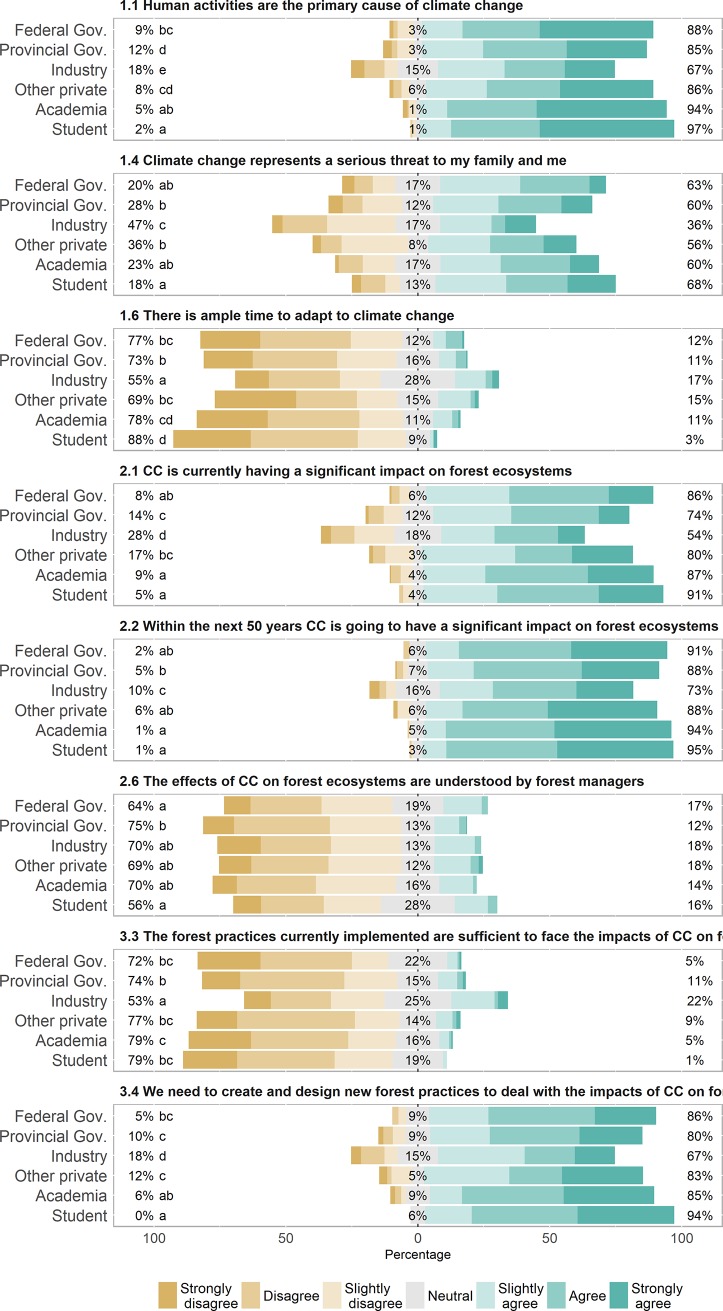
Responses to a survey on perceptions of climate change and its impacts on forest ecosystems by type of stakeholder across the Canadian forest sector (n = 974).The figure includes some of the more relevant results of the survey; the complete results for all the questions are in S2 File. Percentages for each statement represent, from left to right, the amount of disagreements (strongly disagree, disagree, slightly disagree), neutral responses, and agreements (slightly agree, agree, strongly agree). Different letters beside the bars indicate significant differences in the distribution of responses across stakeholder types after a Kruskal-Wallis non-parametric test (n = 974).